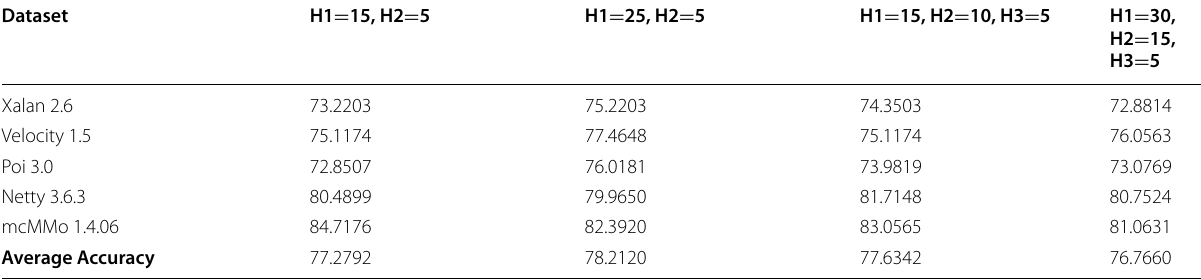
Table 2 Prediction accuracy